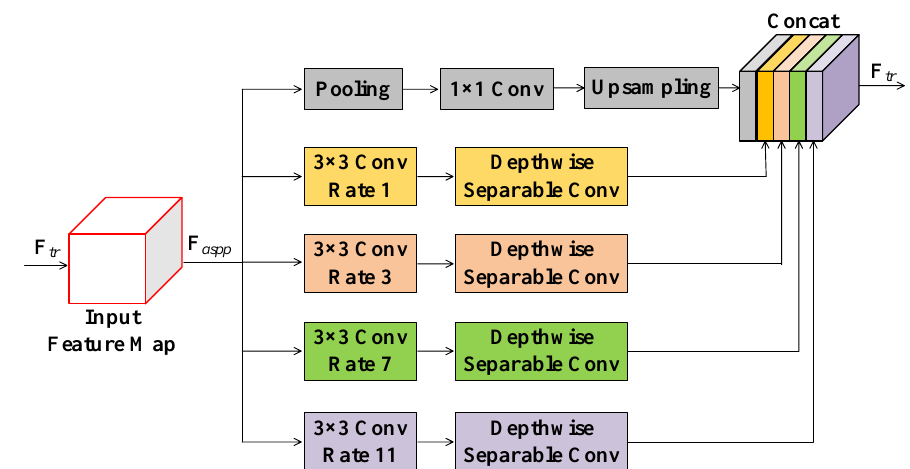
Figure 5. Structure of Atrous Spatial Pyramid Pooling (ASPP) Module.